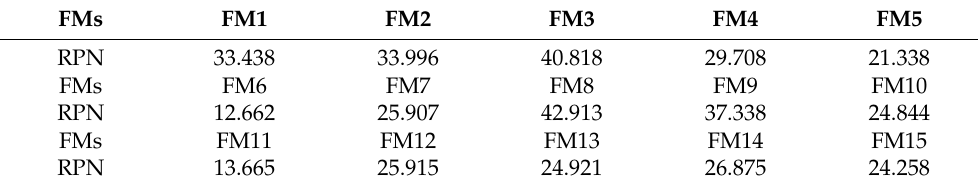
Table 9. The CIS numerical scales for different DM k